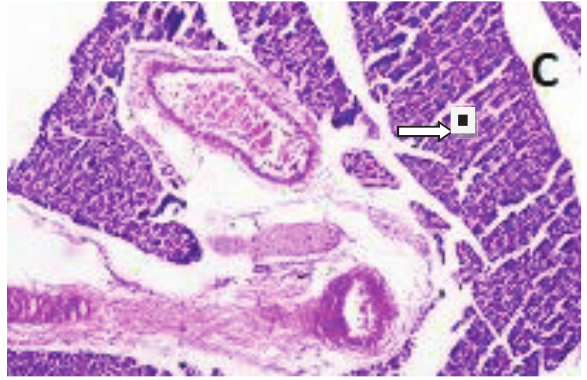
Fig-10: Group F (HFD+STZ+Zinc+halfCana) Restoration of the size and number of islets with mild karyolysis and ballooning (40x;